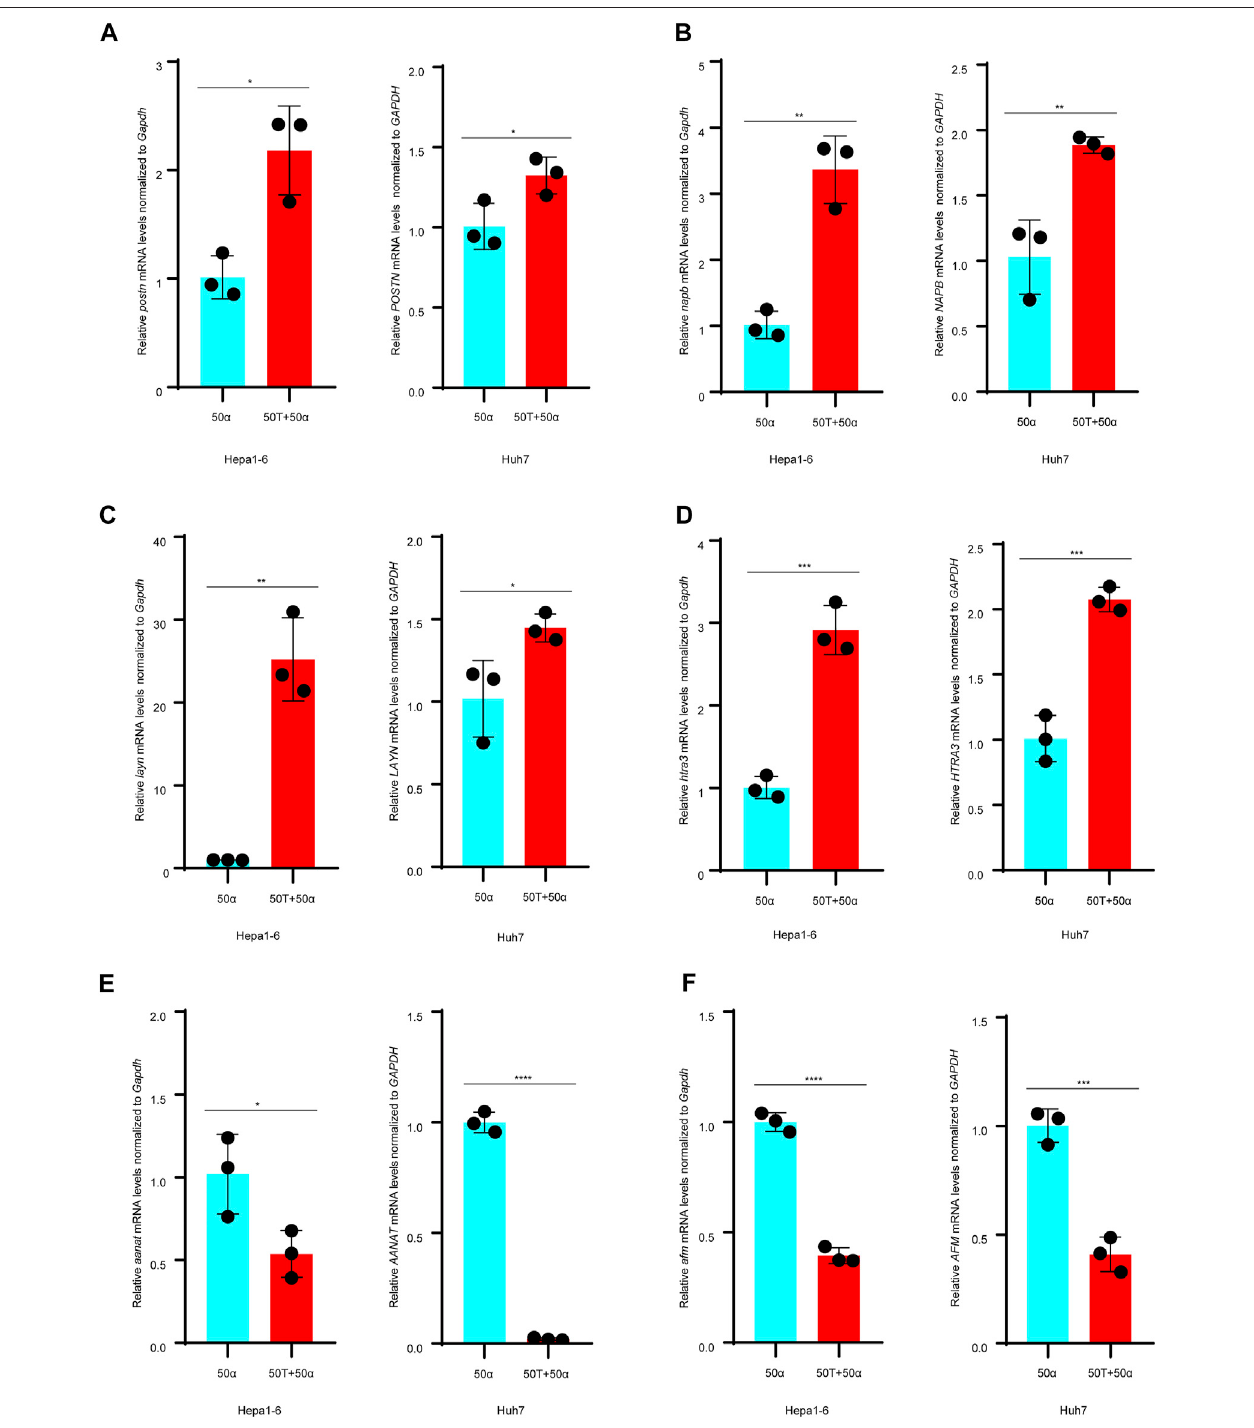
FIGURE 5 | TMAO and TNF- α alter expression of the DEGs in Hepa1-6 cells and Huh7 cells. (A – D) Expression of the POSTN , NAPB , LAYN and HTRA3 mRNAs were signi fi cantly upregulated in Hepa1-6 cells and Huh7 cells treated with 50 ng/ml TNF- α and 50 μ M TMAO in combination compared to cells treated with 50 ng/ml TNF- α alone; results are mean ± SD ( n = 3 per group); Student ’ s t-test. (E,F) On the contrary, 50 ng/ml TNF- α and 50 μ M TMAO in combination signi fi cantly downregulatedtheexpression of AANAT and AFM comparedtocellstreatedwith50 ng/mlTNF- α alone;results aremean±SD( n =3per group); Student ’ st-test.